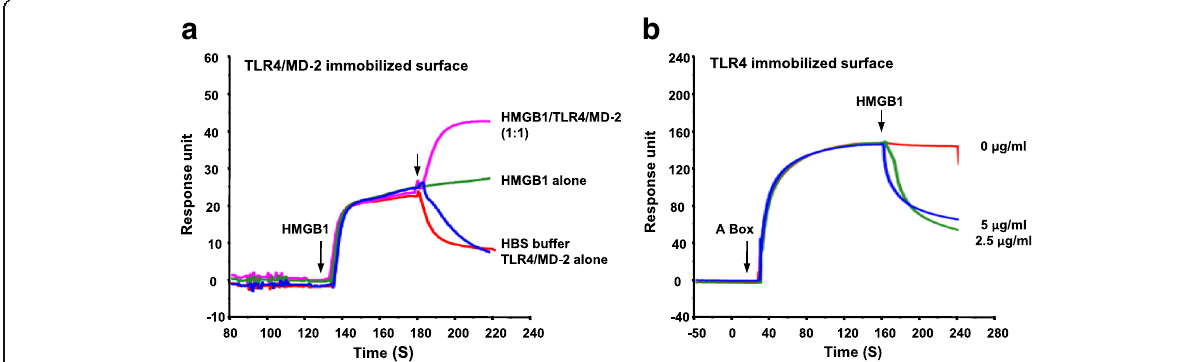
Fig. 5 Ternary complex formation among TLR4/MD-2, TLR4, A-box and HMGB1. a Biacore sensorgram showing molecular interactions, after injecting HMGB1 (100 nM) followed immediately by HBS buffer, HMGB1 (100 nM) or TLR4/MD-2 (100 nM) or mixture of the latter (100 nM each) onto a TLR4/ MD-2 sensor chip surface. b Injecting A-box (10 μ M), followed immediately by A-box (0 μ g/ml of HMGB1) or HMGB1 (2.5 and 5 μ g/ml) onto a